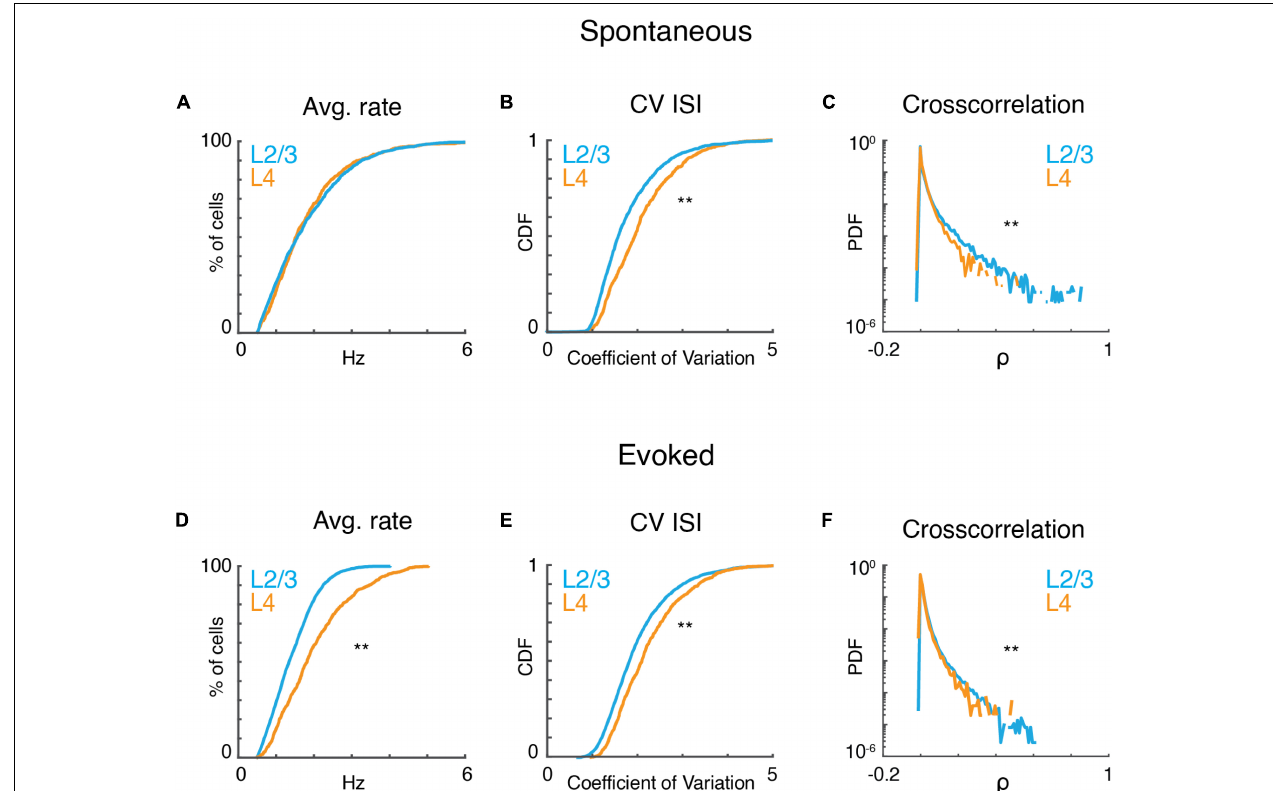
FIGURE 2 | A1 activity is variable and correlated. (A) Cumulative probability distributions of average spike rate for all recorded neurons in L2/3 (blue) and L4 (orange) during ongoing activity ( p rate > 0.84, ranksum). (B) Corresponding cumulative probability distribution of inferred CV inter-spike interval (CV ISI ) for all neurons in L4 (orange) and L2/3 (blue) ( p CV < 10 − 20 , ranksum). (C) Probability distribution of pairwise cross-correlation values for all neurons and experiments for L4 (orange) and L2/3 (blue) ( p CC < 10 − 65 , ranksum). (D–F) Average spike rate, CV ISI , and pairwise cross-correlation for evoked neuronal activity ( p rate < 10 − 55 , p CV < 10 − 20 , p CC < 10 − 301 ,